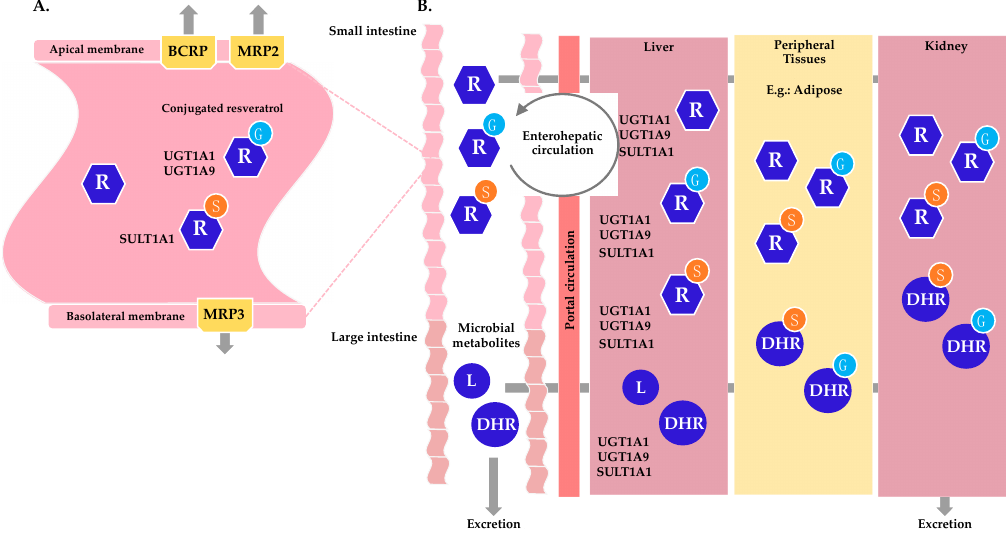
Figure 2. Metabolic fate and biotransformation of resveratrol in the human gastro-intestinal tract, and metabolism in different organs. ( A ) Metabolism of resveratrol (R) in the small intestine’s enterocyte. Resveratrol is absorbed into the enterocyte and undergoes sulfation (S) by SULT1A1 and glucuronidation (G) by UGT1A1 and UGTA9. Conjugated resveratrol exits the cell via BRCP and MRP2 transporters on the apical membrane and MRP3 on the basolateral membrane. A small faction of resveratrol escapes conjugation and exits the enterocyte via the basolateral membrane. ( B ) Integrated human metabolism of resveratrol. Resveratrol and conjugated metabolites exit the apical membrane of the small intestine and move towards the large intestine where they can be metabolized by the gut microbiota to generate dihydroresveratrol (DHR), lunularin (L) and 3,4’-dihydroxy- trans -stilbene (not shown). Resveratrol and metabolites that exit the enterocyte enter portal circulation. The liver expresses SULT1A1, UGT1A1 and UGTA9, which can further conjugate resveratrol. In addition, conjugated resveratrol and metabolites undergo enterohepatic circulation, leaving the liver to be reabsorbed in the intestine after hydrolysis, and entering portal circulation to reach the liver again for further metabolism. From the liver, resveratrol and metabolites enter systemic circulation and are absorbed by peripheral tissues, such as adipose tissue. The kidneys also participate in the metabolism of resveratrol, leading to excretion of polar resveratrol metabolites.